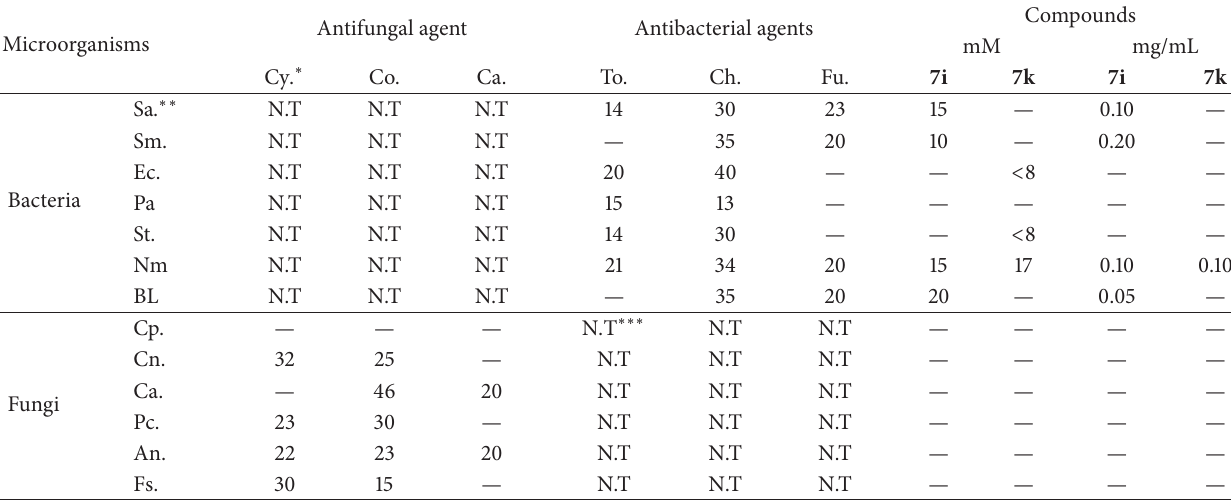
Table 2: Antimicrobial activity (zones of inhibition, mm) and a minimum inhibitory concentration (MIC, mg/ml) of 7i and 7k comparing with several standard antimicrobial drugs.